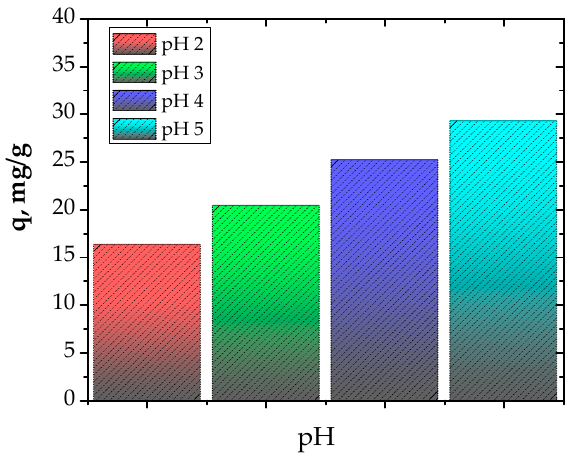
6 of 13 Figure 2. SEM image for raw fly ash. Table 3. The chemical composition for raw fly ash, % atomic. O